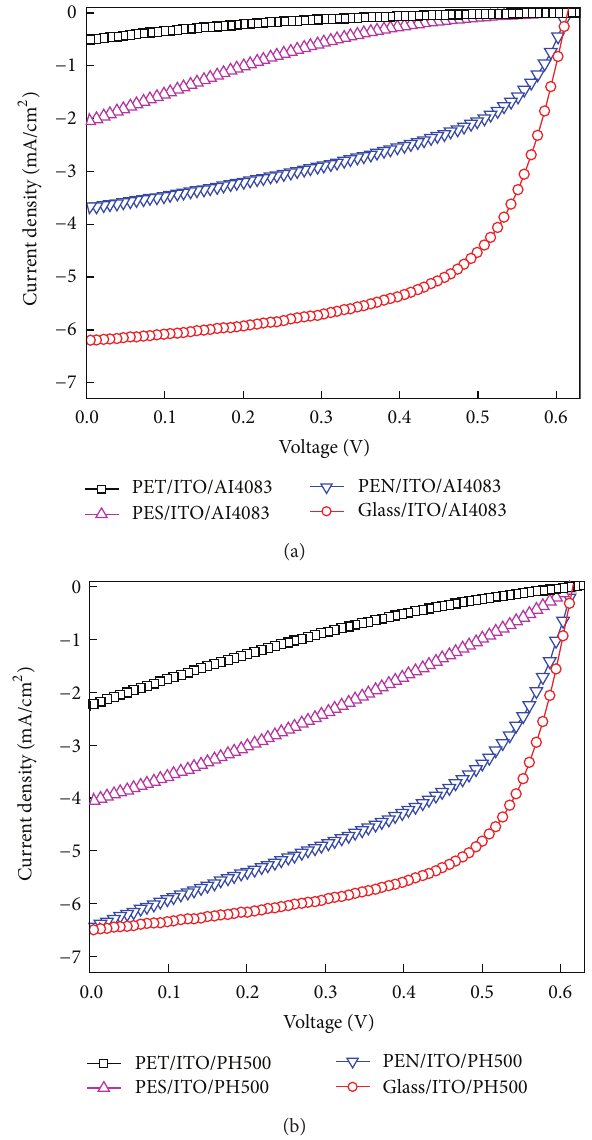
Figure 3: Current density-voltage ( J-V ) characteristics of OPV devices fabricated using four different ITO substrates and hole- collecting buffer layers (PEDOT:PSS: (a) AI4083 and (b) PH500). All measurements were performed under illumination of simulated solar light (AM1.5, 100mW/cm 2